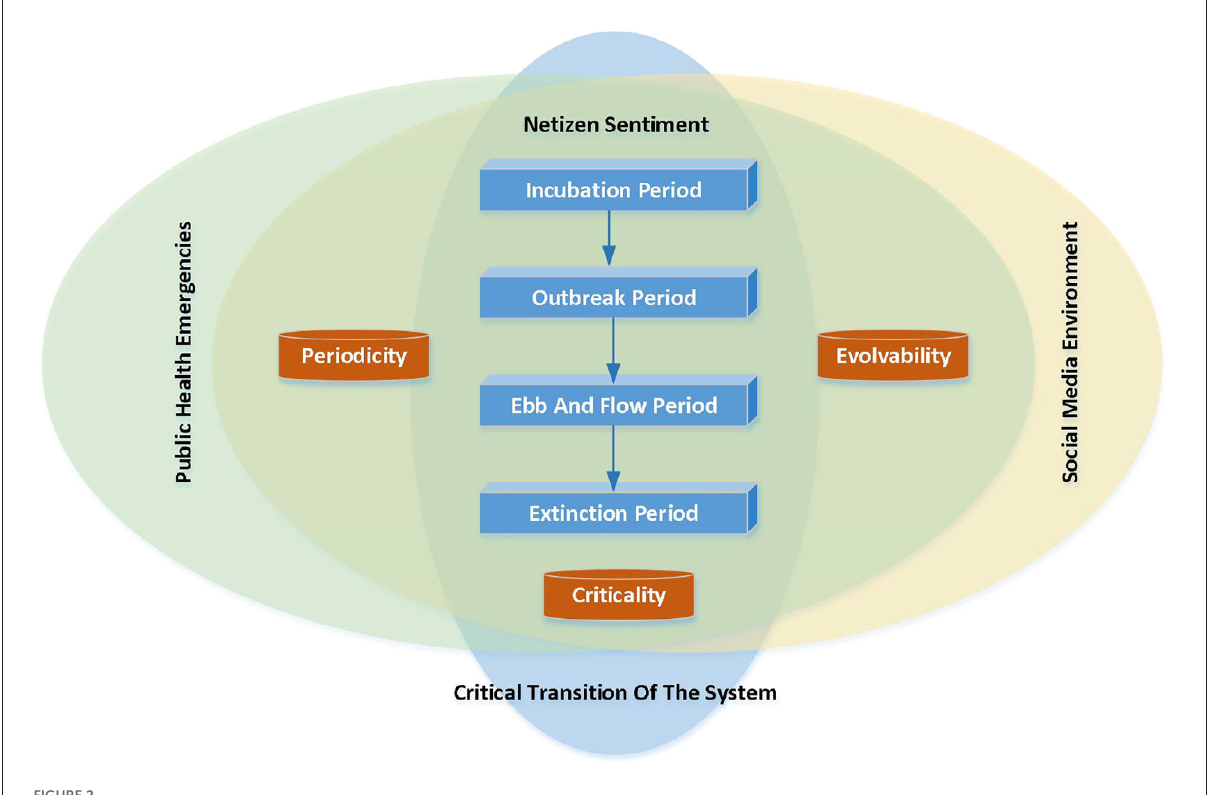
FIGURE2 The critical transition of public sentiment